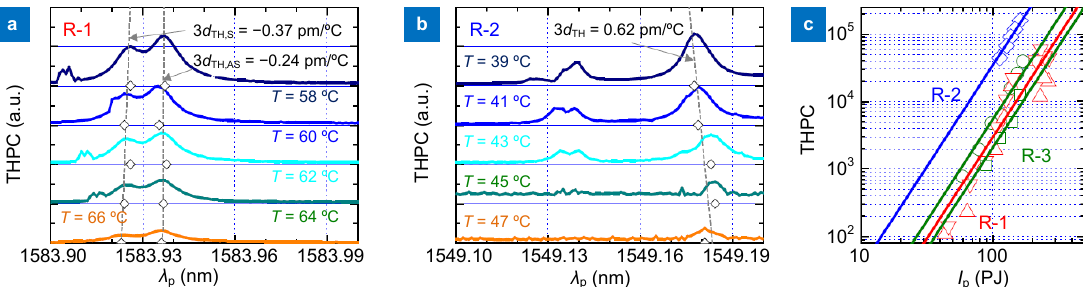
Fig. 4. | ( a – b ) Measured spectra of all the TE athermal TH modes in MRRs of R-1 (a) and R-2 (b) that are thermal matched, i.e. ∆ τ ≈ 0. In (a) and (b), the measured wavelengths of the resonance peak of TH modes at different T are shown in open diamonds. The corresponding fitted TDWS of TH modes are shown in grey dashed lines. ( c ) The measured photon count on the peak of different athermal TH modes as a function of I p . The solid lines show the cubic TH-pump relationship for (a) – (b) as well as Figs. 5(c) and 5(e) for comparison. The data and fitting curves for R-1, R-2, R-3 are shown in blue, red, and green,